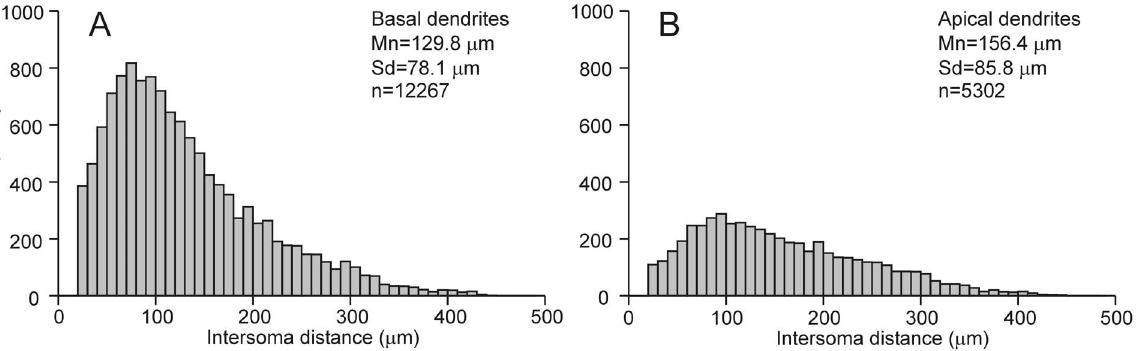
Figure 8. Frequency distribution of intersoma Euclidean distances between connected neurons. A , Connections via basal dendrites. B , Connections via apical dendrites. Note that the minimum intersoma distance with which the network was created was 20 m m.